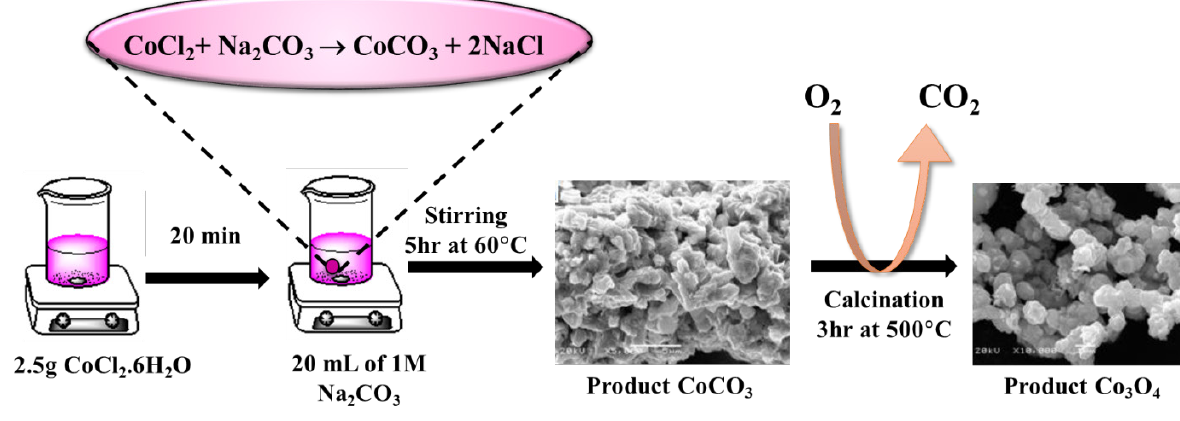
Figure 4: Preparation scheme of product Co3O4 via co-precipitation method followed by